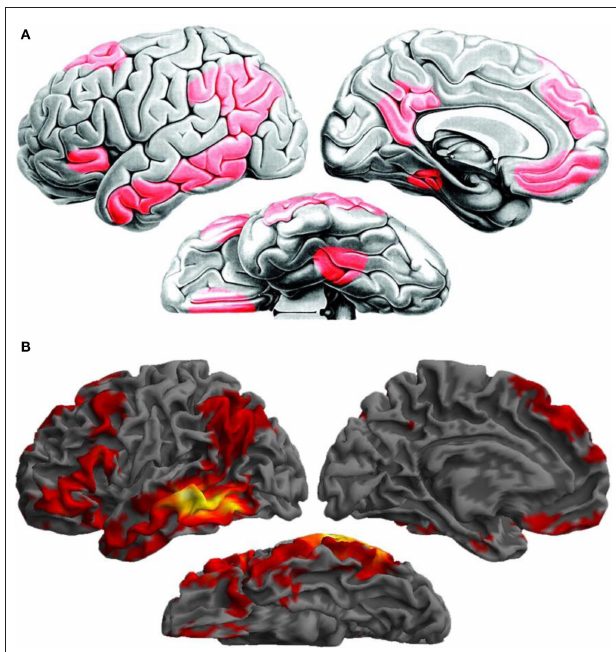
Figure 16 | (A) A large-scale network for verbal semantic processing identified by a meta-analysis of 120 functional neuroimaging studies, and the underlying structural connections inferred from tracing studies of the homologous regions in the macaque from (Reprinted with permission from Binder et al., 2009, page 2779, Figure 7). (B) Resting functional connectivity pattern for the left posterior MTG ROI, assessed in the present investigation, is largely consistent with the meta-analysis